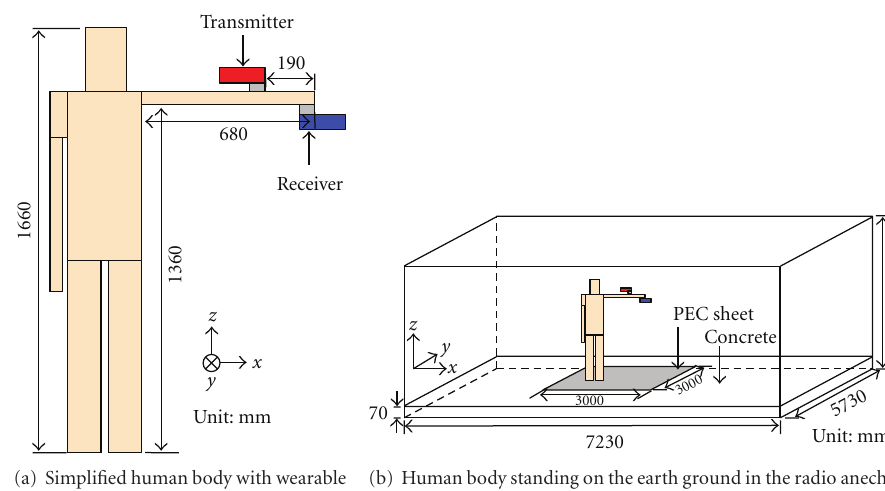
Figure 5: FDTD calculation